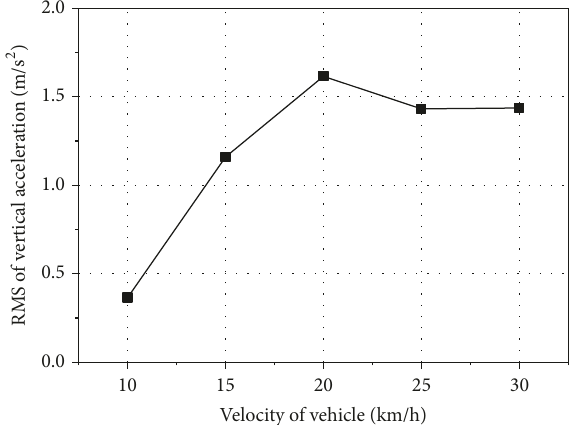
Figure 2: Measured acceleration of car body at different